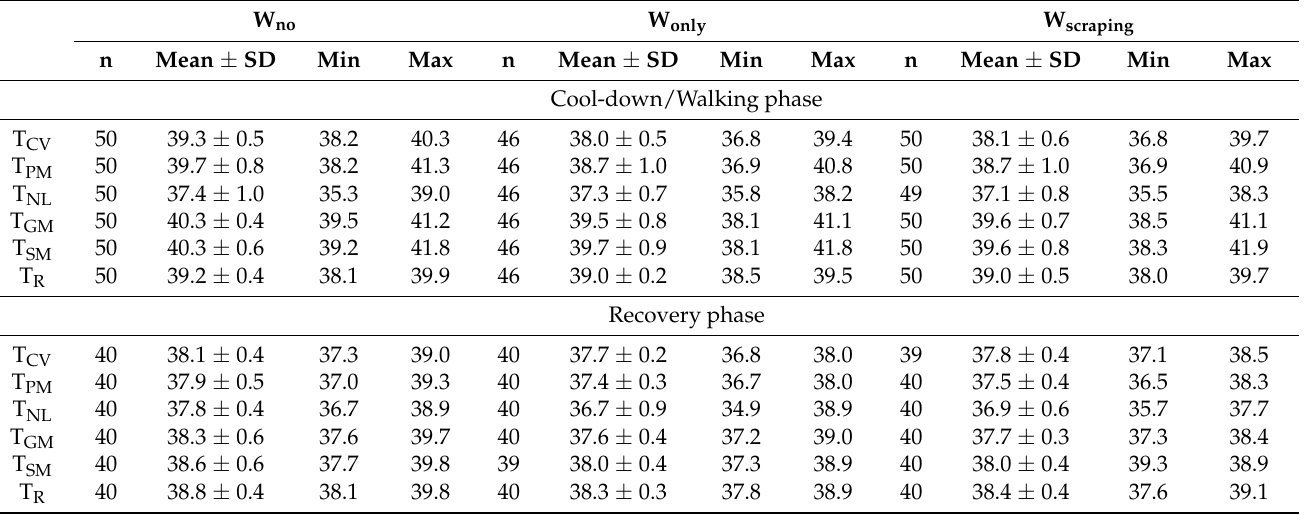
Table A2. Descriptive statistics of each body temperature by cool-down method and phase during the entire experimental program. (Unit: ◦